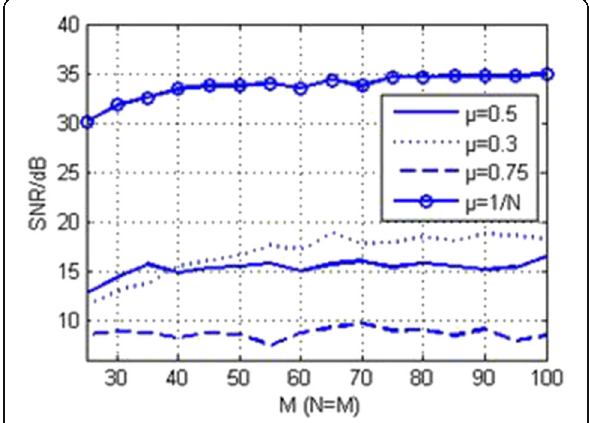
Fig. 5 SNR of the sampling schemes with redundancy as μ = 1/N relating to this study, and μ = 0.5, μ = 0.3, μ = 0.75 relating to